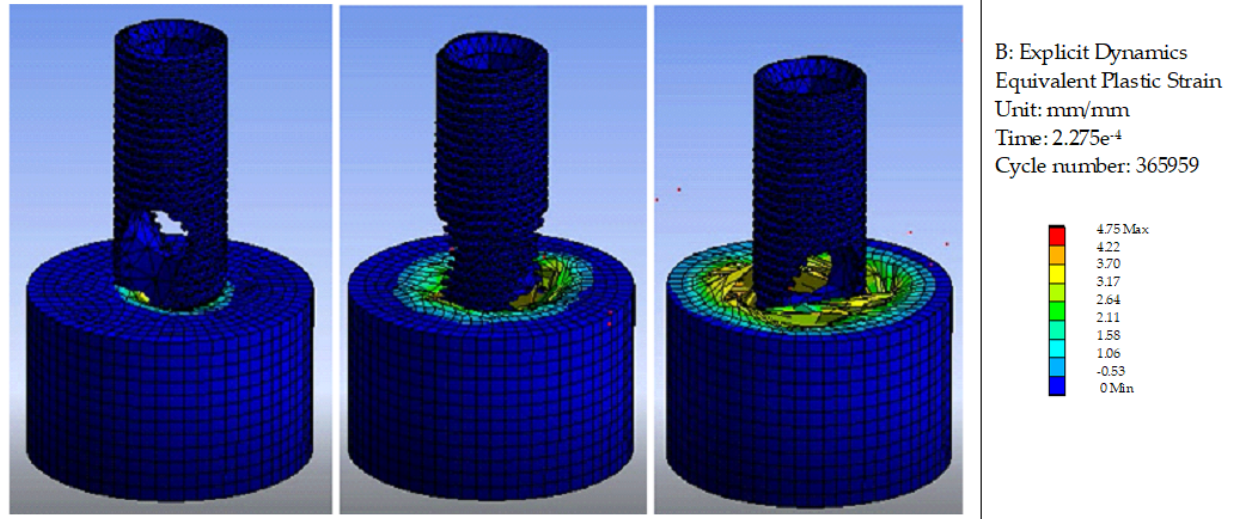
Figure 4. Numerical results of the plastic strain at different time instants.